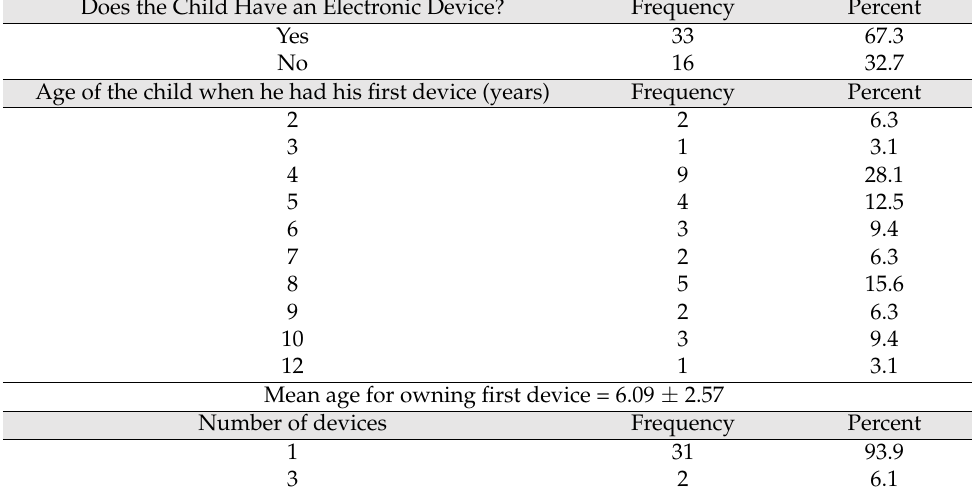
Table 3. Descriptive information on the child’s technology